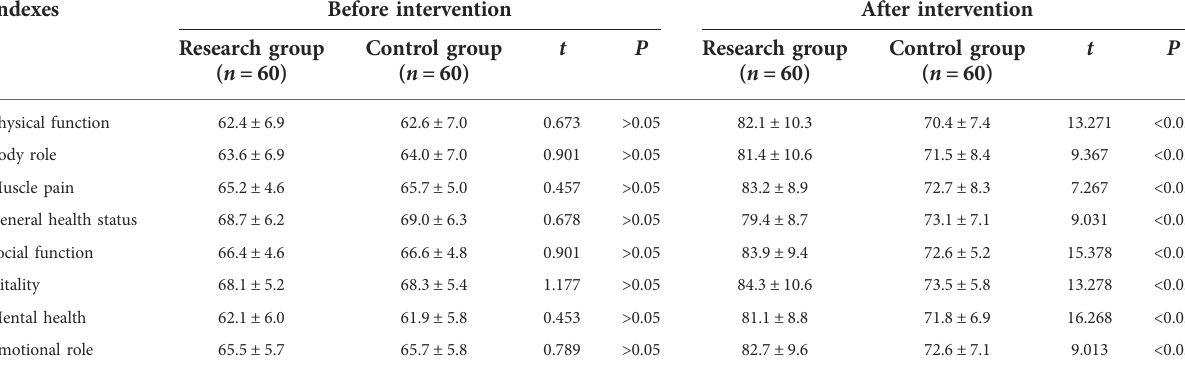
TABLE 2 Comparison of quality of life scores between the two groups before and after intervention (score). Indexes